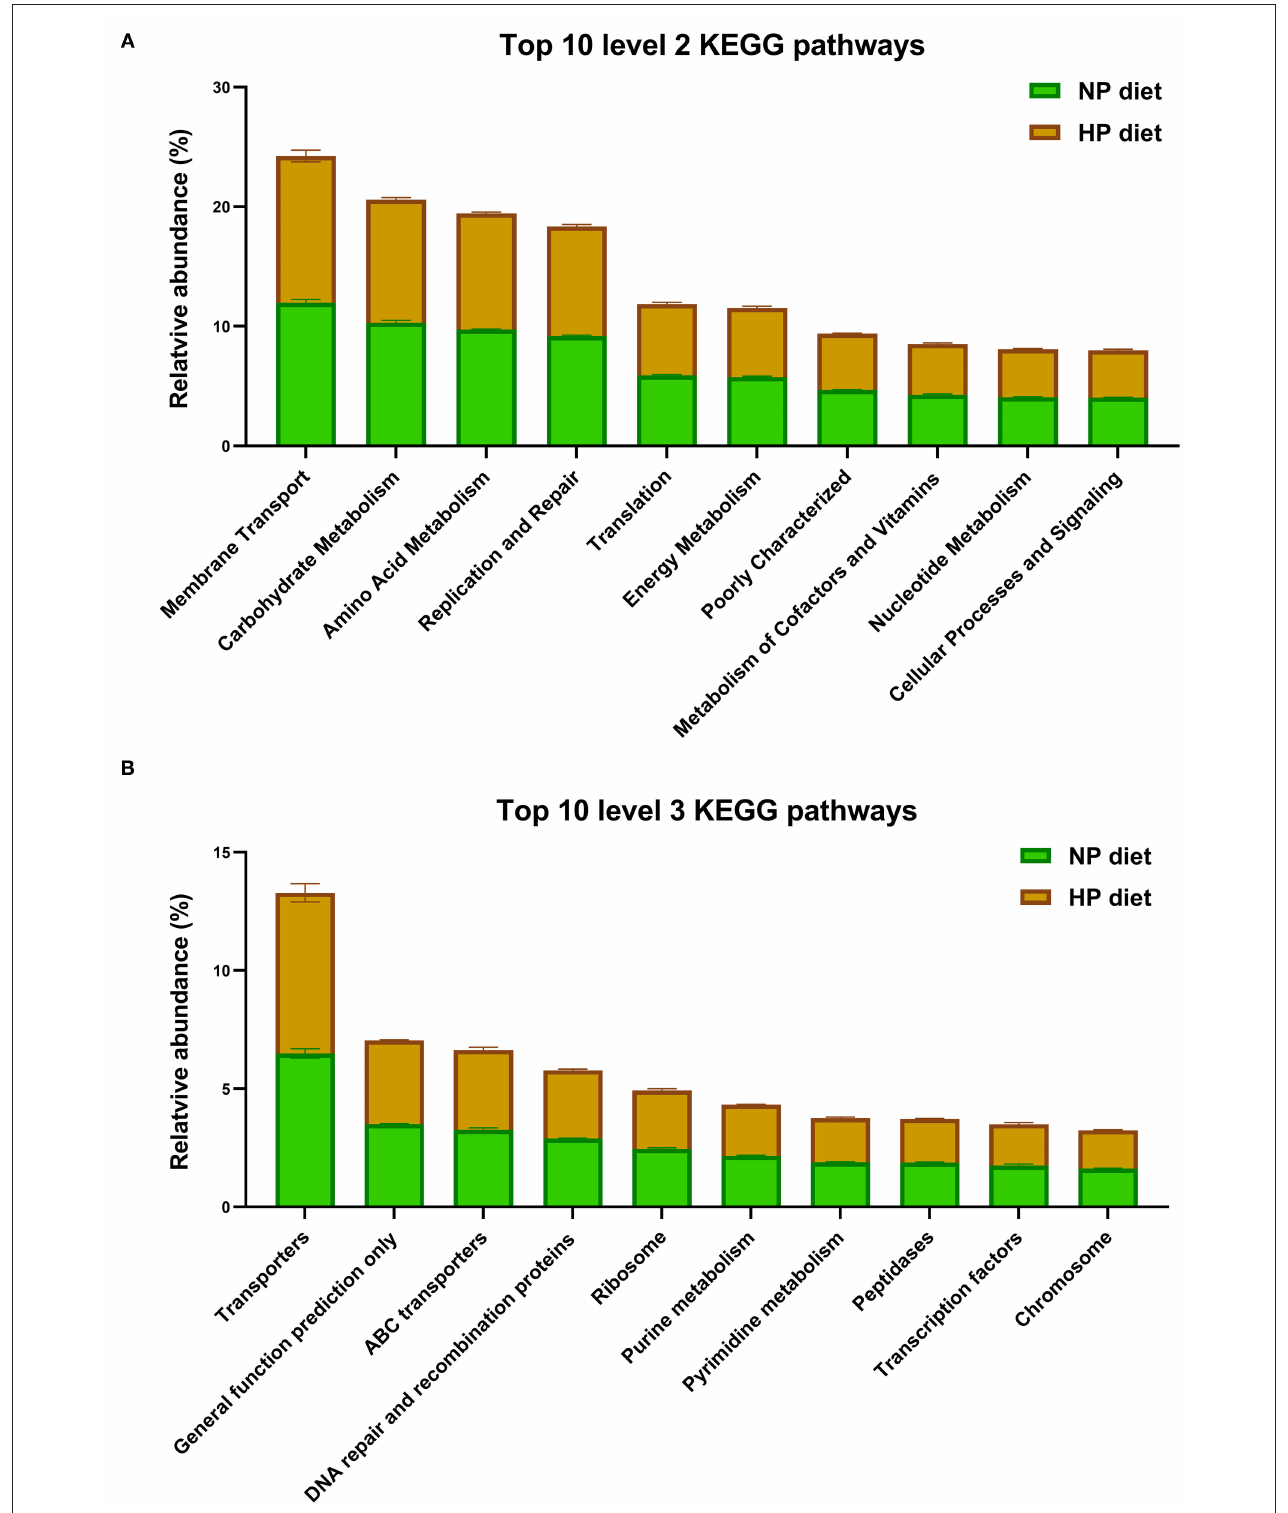
FIGURE 5 | Top 10 predicted metagenomic functions at level 2 (A) and level 3 (B) of the KEGG pathways.